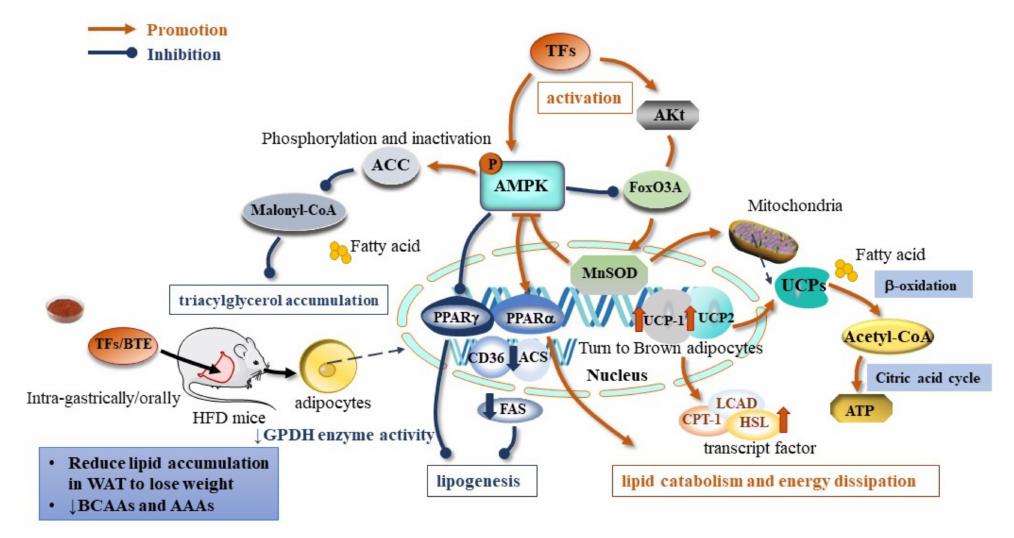
Figure 2. Molecular mechanism of TFs on antiobesity effect ( ↓ indicates